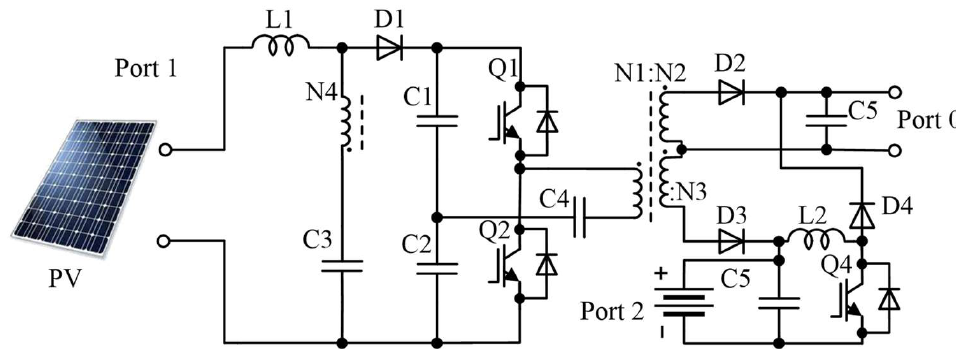
Figure 14. PV-Partially Isolated Three-Port Converter [73].